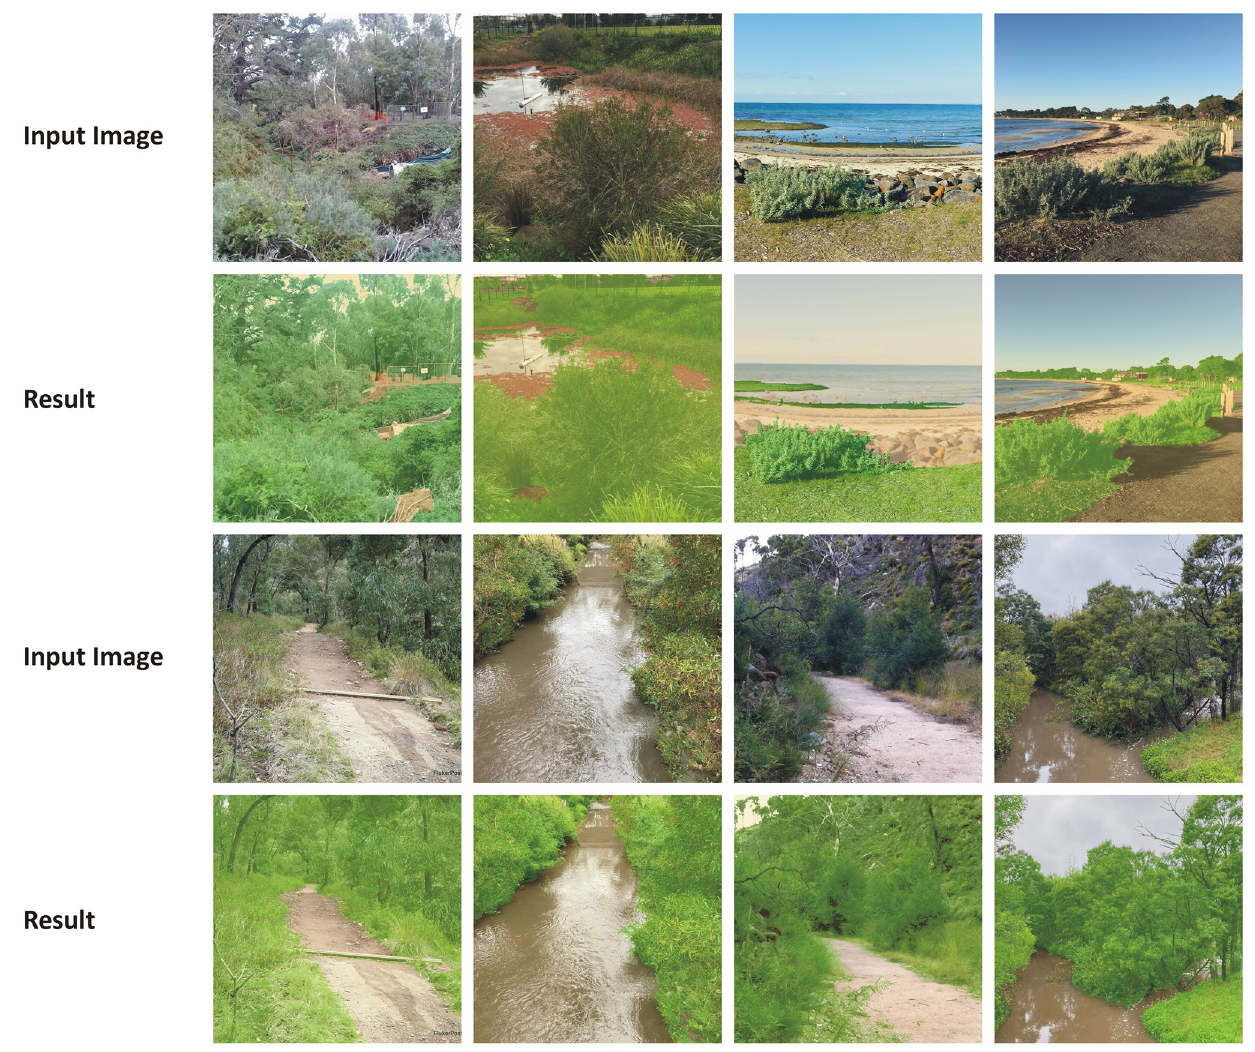
Fig 10. Some sample segmentation results for the randomly selected test input images.